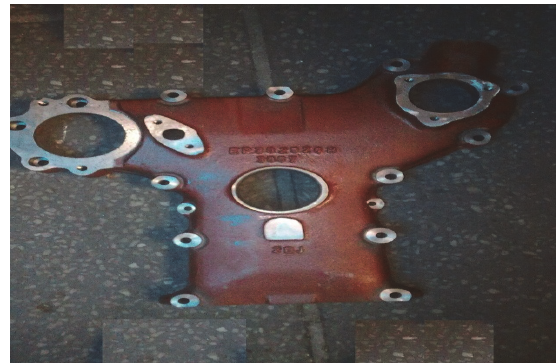
Fig. 1(a). Timing gear box cover- outer